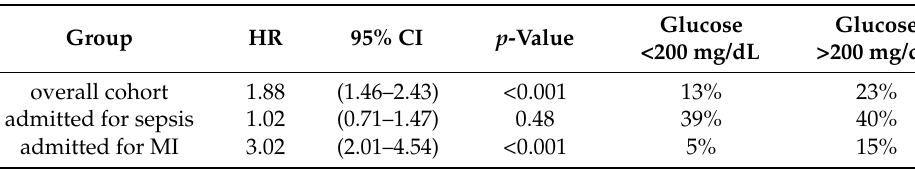
Table 4. Severe hyperglycemia was associated with adverse short-term outcome in the overall cohort (23% vs. 13%; p < 0.001) and patients admitted for AMI (15% vs. 5%; p < 0.001) but not for septic patients (39% vs. 40%; p = 0.48).